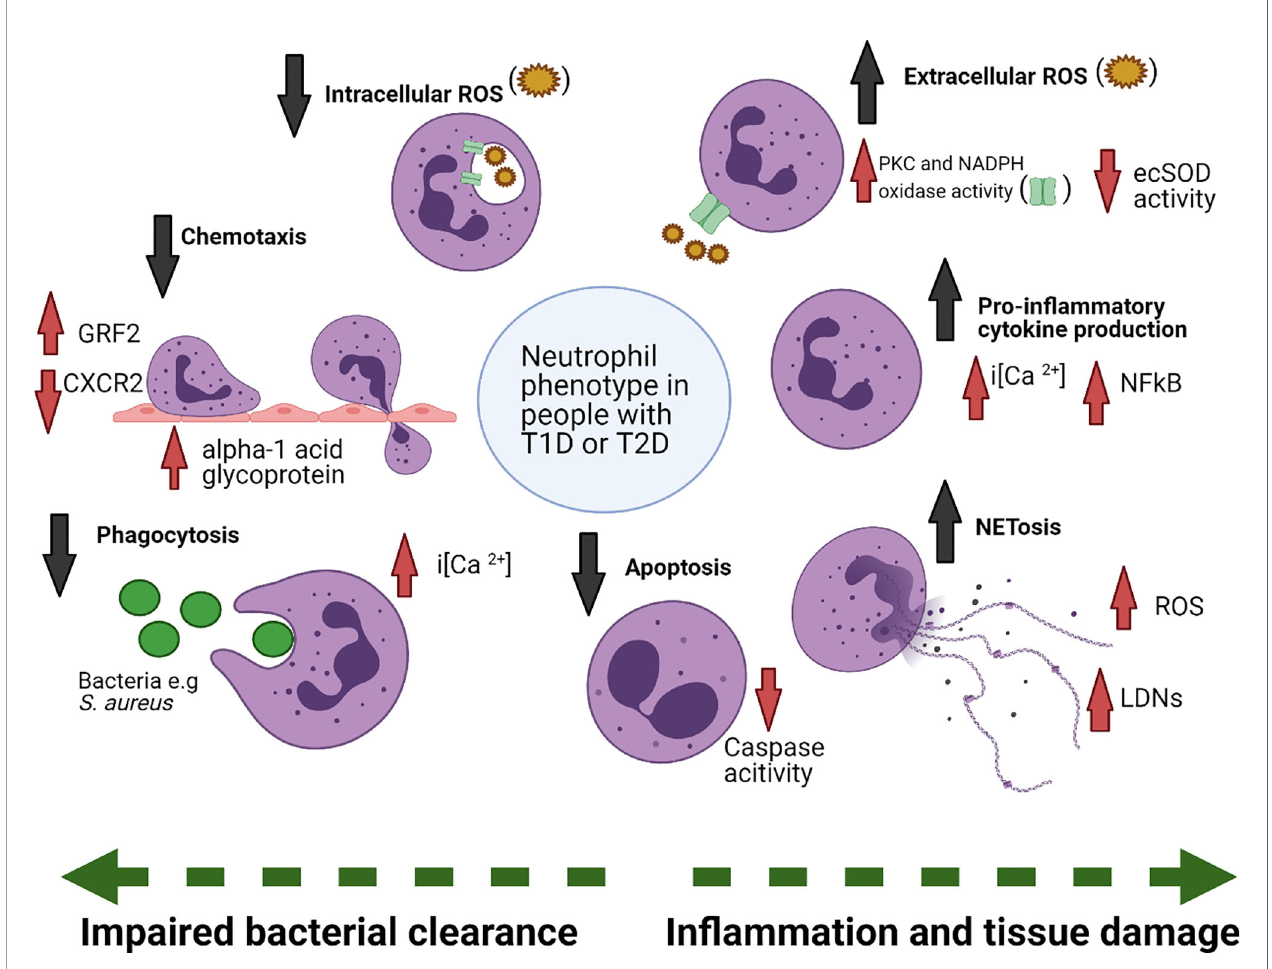
FIGURE 2 | Summary of changes in neutrophil function in diabetes. Neutrophils in diabetes are functionally altered, due to exposure to the diabetic microenvironment, including changes to blood glucose as well as other factors. Phagocytosis, chemotaxis, intracellular ROS production and apoptosis are reduced in diabetes, whereas extracellular ROS, cytokines and NETosis are increased. Examples of mechanisms underpinning the functional changes are also noted. extracellular superoxide dismutase (ecSOD), protein kinase C (PKC), nicotinamide adenine dinucleotide phosphate (NADPH), reactive oxygen species (ROS), Nuclear factor- k B (NF- k B), low-density neutrophils (LDNs), G protein coupled receptor kinase-2 (GRK2). Figure created with